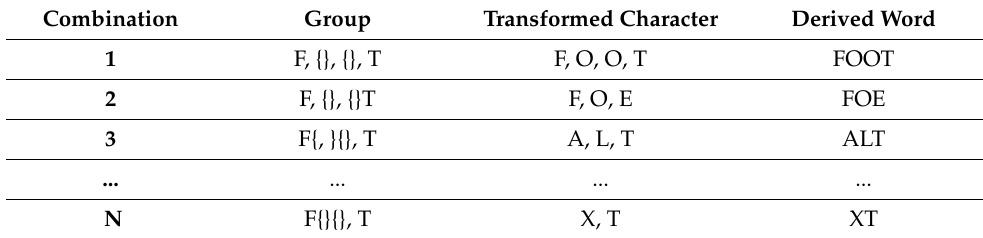
Table 5. An example on derived